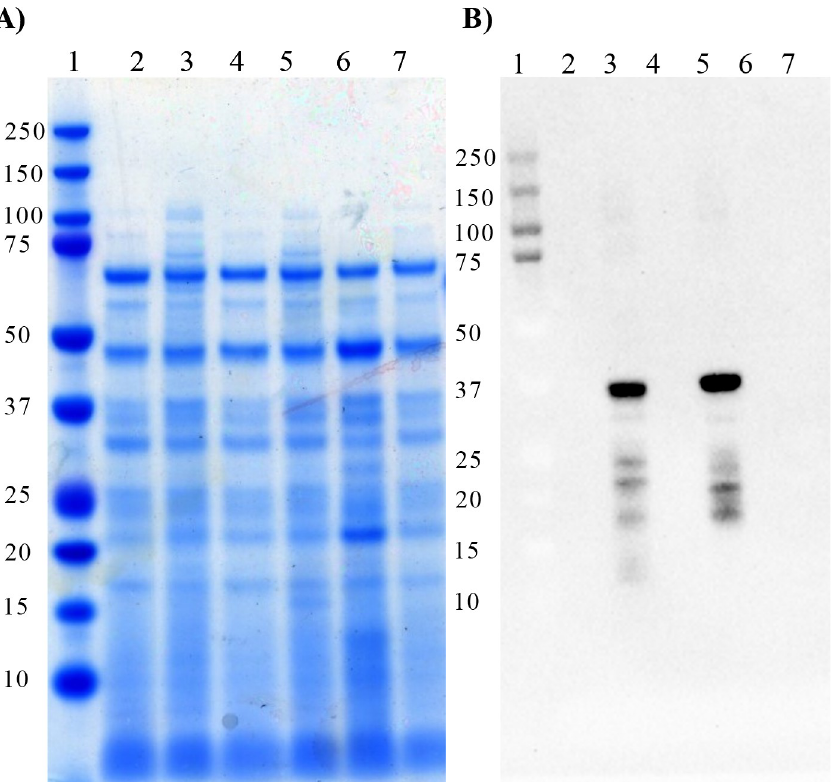
Fig 3. Verification of expression of bb0572 in E coli . Coomassie stained SDS-PAGE gel ( A ) and anti-His tag Western blot ( B ) of whole cell lysate from uninduced (lanes (2, 4 and 6) and IPTG induced (lanes 3, 5 and 7) cultures of E . coli expressing the WT bb0572 (lane 2 and 3), mutated bb0572 Δ CFF/DGD/I (lane 4 and 5) or possessing the empty pET28a vector (lane 6 and 7). Lane 1(ladder).